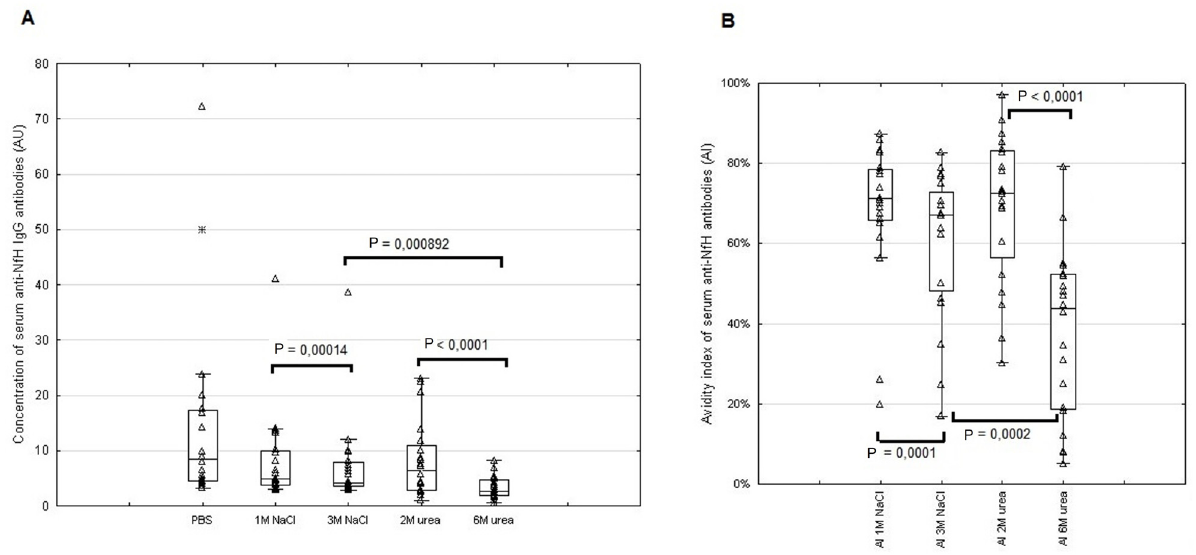
Fig. 2. Comparison of NaCl and urea as chaotropic agents in the ELISA for the avidity determination of anti-NfH IgG antibodies. The box plots include median (horizontal line ⎯ ), values from the 25 th to the 75 th percentiles (boxes); bars (whiskers) above and below the box indicate the range of non-outliers. Non-outliers are indicated by triangles. Outliers and extremes are shown by circles and